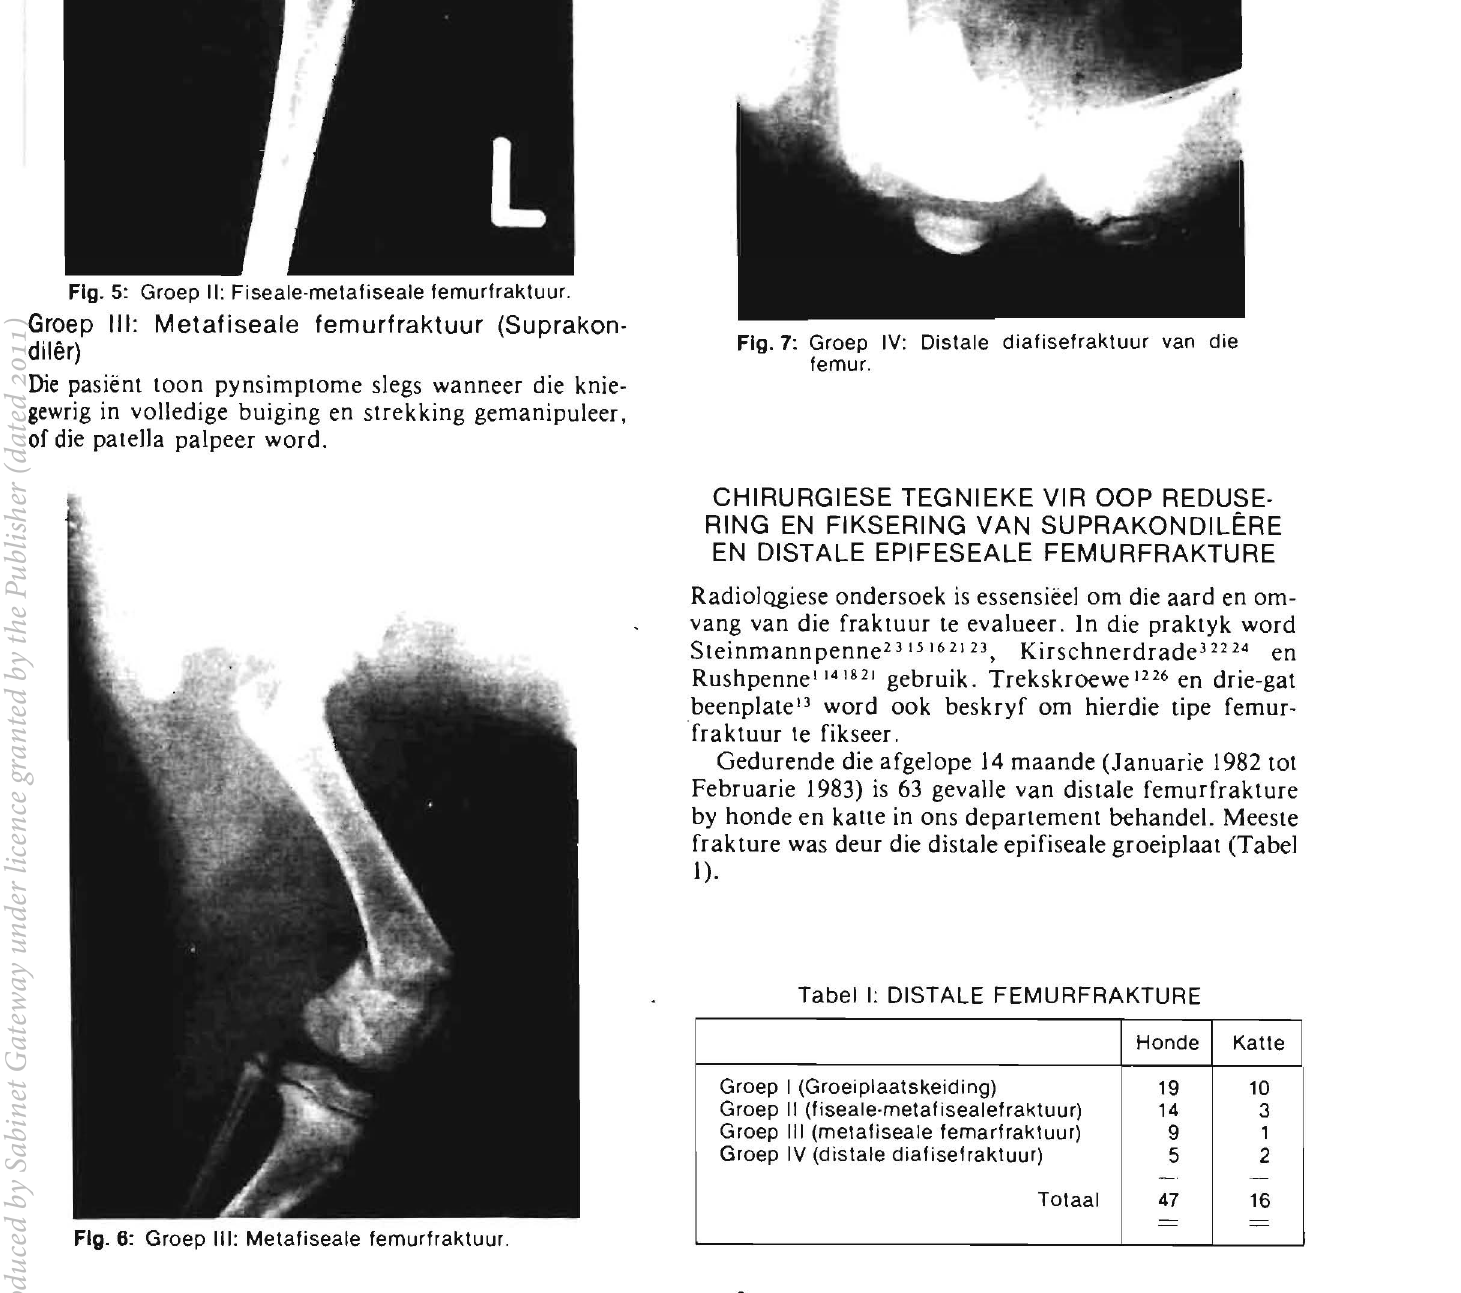
Fig. 5: Groep II: Fiseale·metafiseale femuriraktuur. Groep III: Metafiseale femurfraktuur (Suprakon· diler)